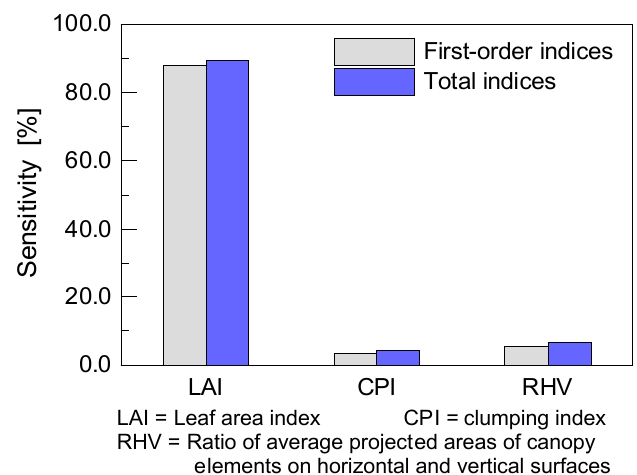
Figure 1. First-order and total-order indices of sensitivity analysis for Equation (3).